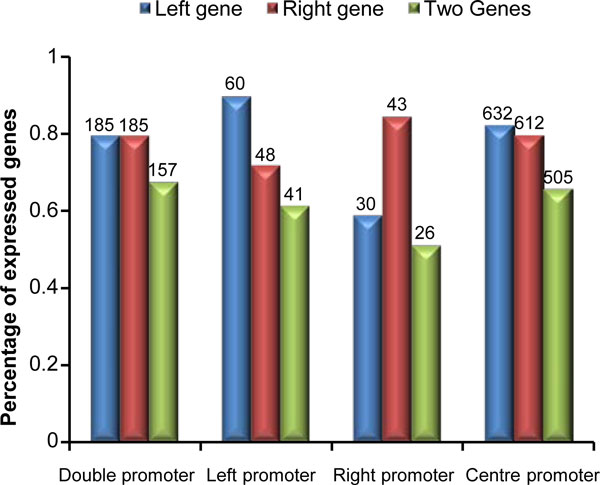
Percentage of expressed genes associated with 4 types of promoters. The blue, red and green colors correspond to expressed left genes, right genes and 2 genes, respectively. The numbers on the top of the bars give the total of expressed genes.